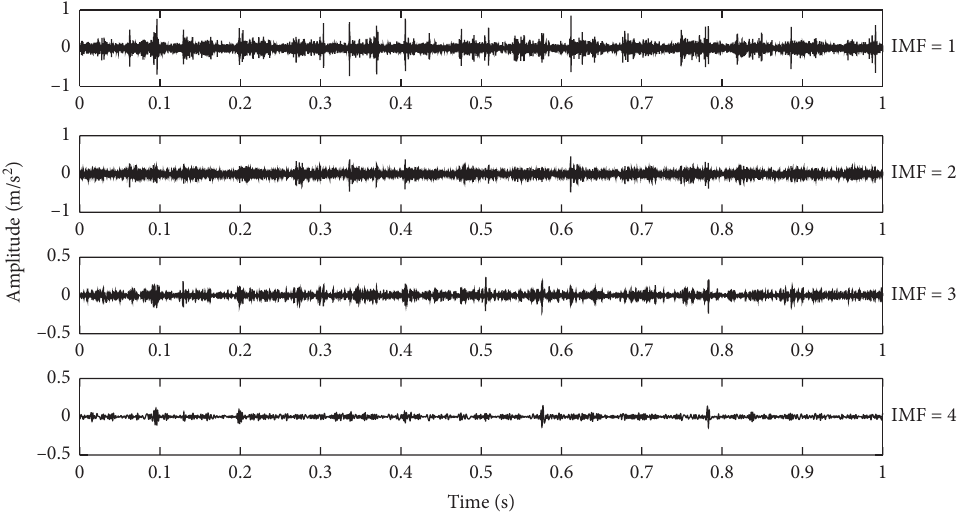
Figure 20: The first four IMF components after EMD.